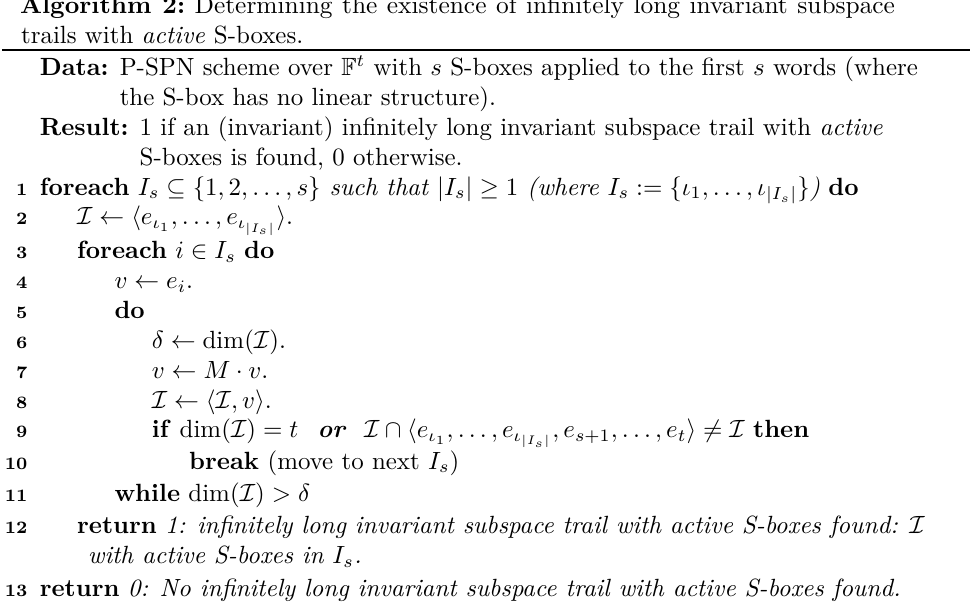
Algorithm 2: Determining the existence of infinitely long invariant subspace trails with active